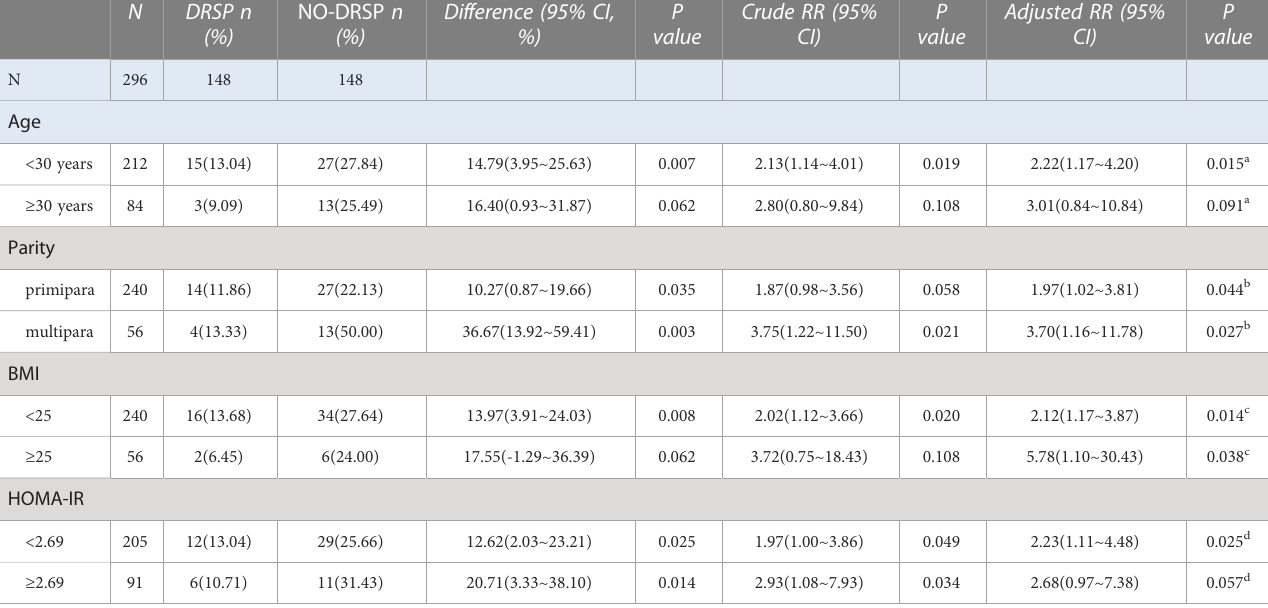
TABLE 3 Comparison of total adverse pregnancy outcomes between the two groups in different subgroups ( vs .